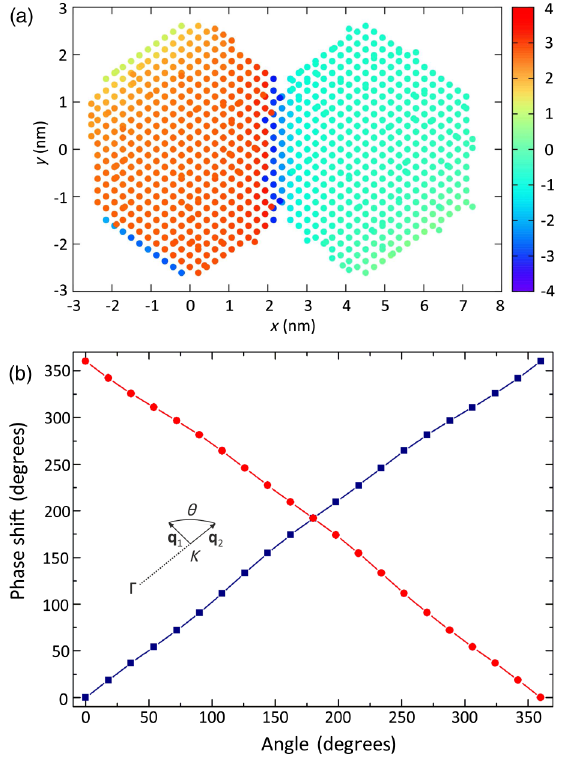
FIG. 7 (color online). Chirality of the 1 S wave functions of the CdSe honeycomb lattice compared with atomic chirality in graphene. (a) Phase shift (radians) on each atomic orbital between the electronic states of the lowest conduction band of the graphene-type honeycomb superlattice of the compound CdSe [Fig. 2(a)]. The phase shift is calculated at K þ q 1 and K þ q 2 , with j q 1 j ¼ j q 2 j ¼ 0 . 05 j K j and an angle between q 1 and q 2 of 3.8 rad, for each lateral atomic position in the lattice plane. (b) Difference between the phase of the wave function at the center of nanocrystals A and B versus the angle between q 1 and q 2 , at K (square blue symbols) and K 0 (circular red symbols). Similar results are obtained for the 1 P Dirac cone.